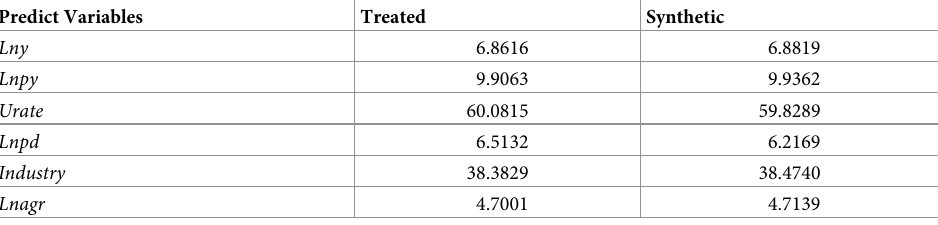
Table 4. Treatment and synthetic control groups of the predictive variables for COD.